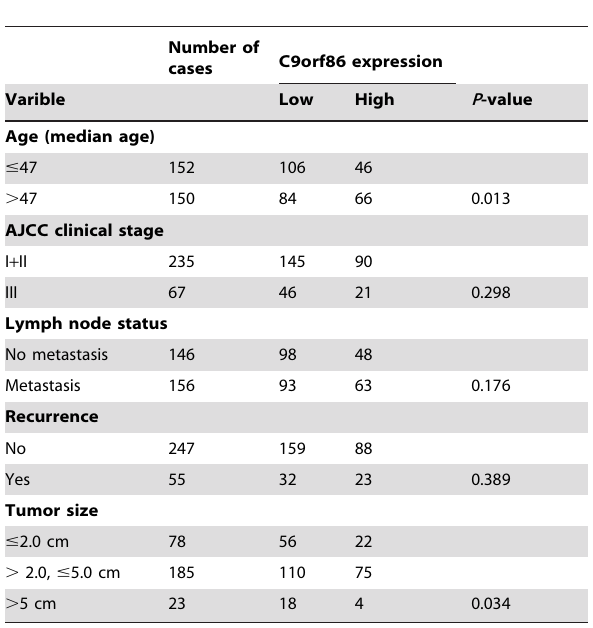
Table 1. Relationship between C9orf86 expression level and clinicopathological variables of BC